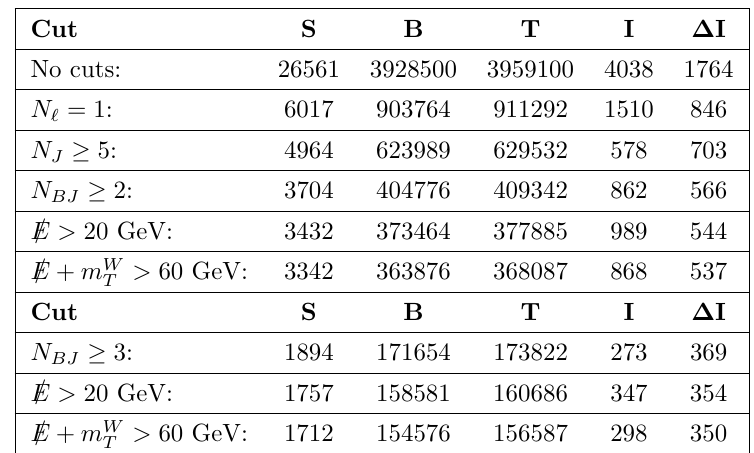
Cut (cid:13)ow results presented in expected event yield with 300 fb (cid:0) 1 of luminosity for the m mod+ benchmark with 10,000,000 events for each sample. h